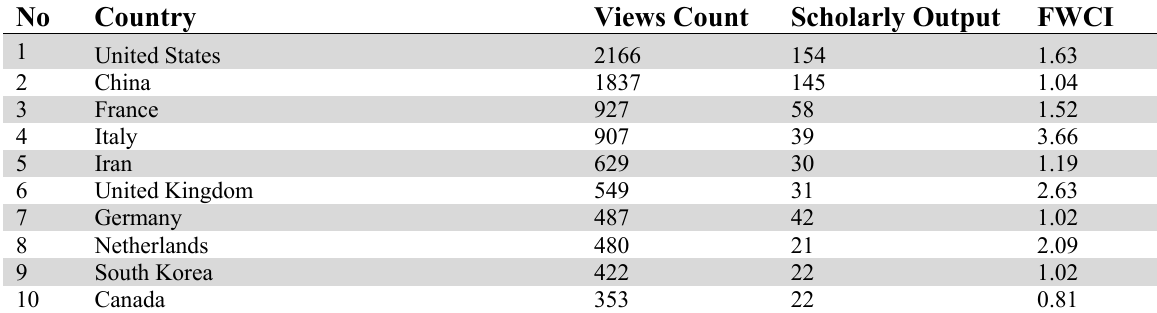
Top ten high view counts countries in field MBSO.